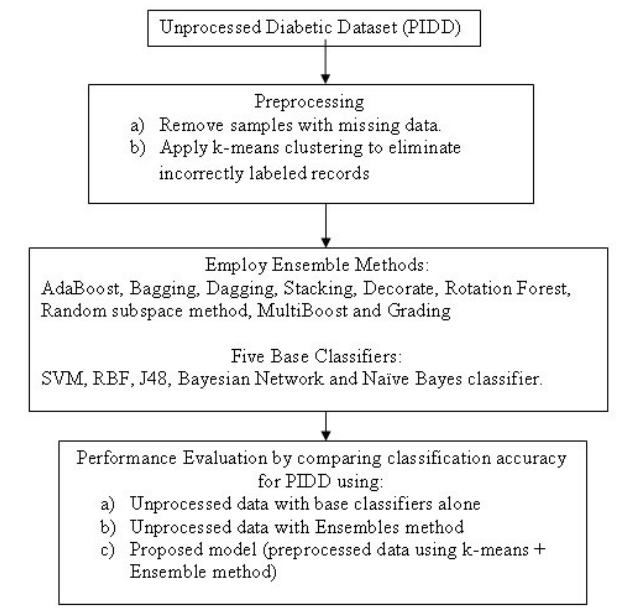
Figure 2. Working of the proposed model: Cascaded k -means + ensembles for enhanced categorization of diabetic